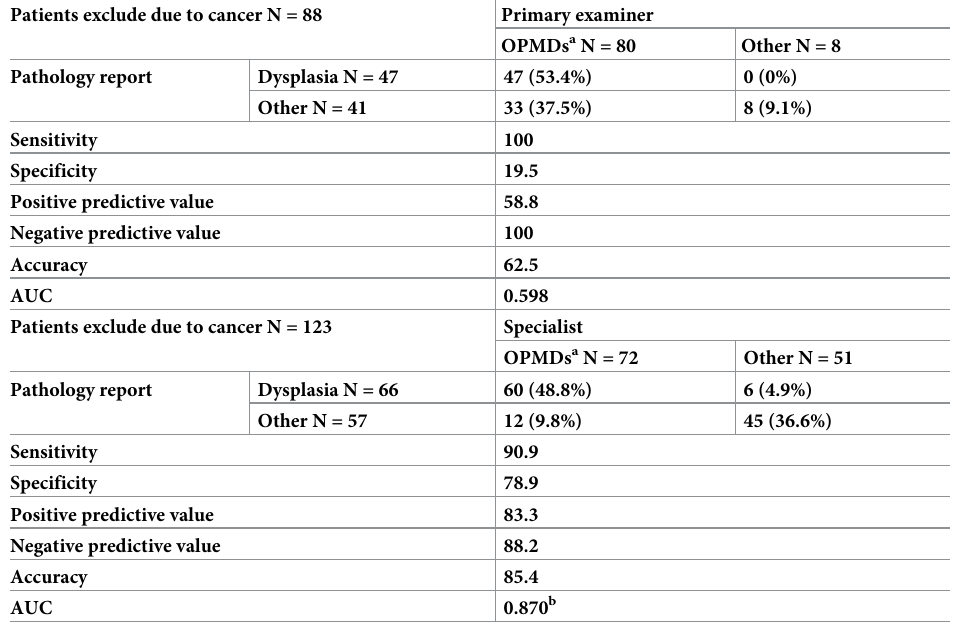
Table 3. Accuracy of diagnoses of oral potentially malignant disorders with dysplasia by the primary examiner and the specialist.